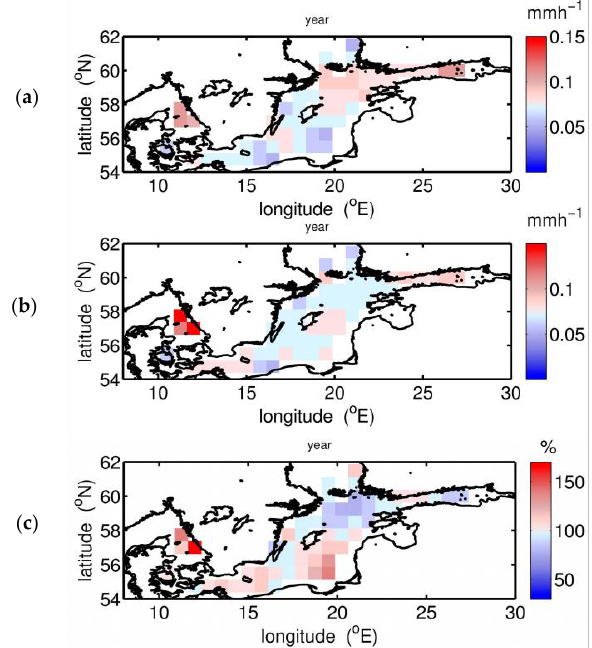
Figure 3. Mean annual precipitations rates in mm·h −1 derived from collocated precipitation events; ( a ) observations, ( b ) ERA-Interim, ( c ) ratio of ERA-Interim to observed precipitation rates.